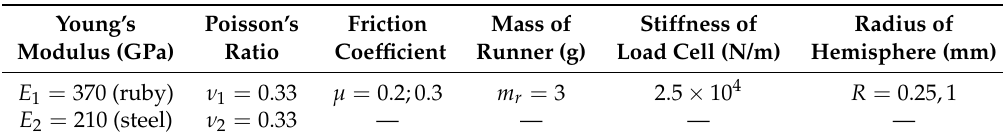
Table 1. Data used for numerical simulations.